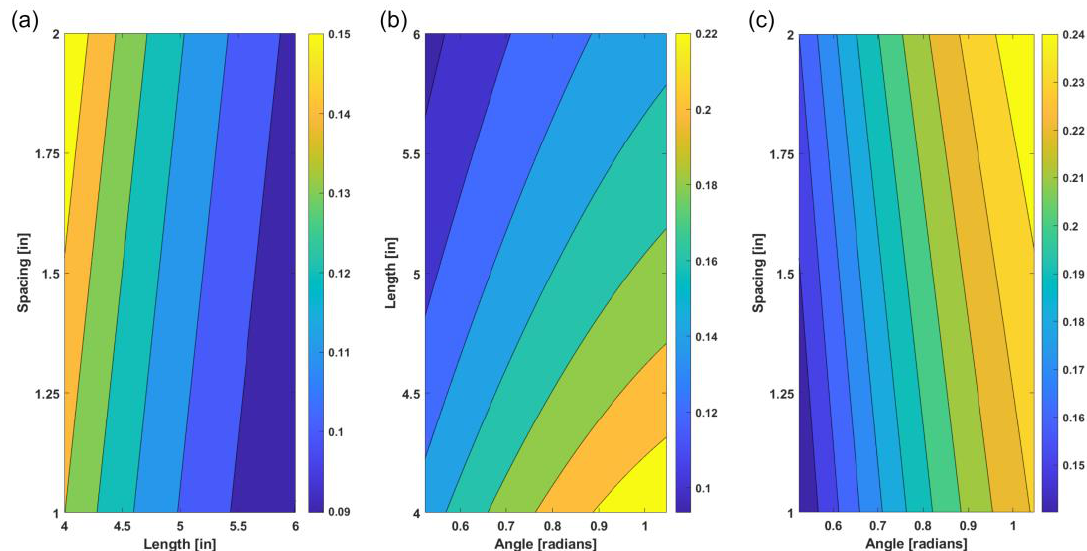
Figure 4. Geometric curvature trends. ( a ) The effect on curvature as the length of the second fish scale and spacing in between the scales vary. ( b ) The effect on curvature as the angle of the second fish scale and the spacing in between the scales vary. ( c ) The effect on curvature as the length of the second scale and angle of the scale varies.